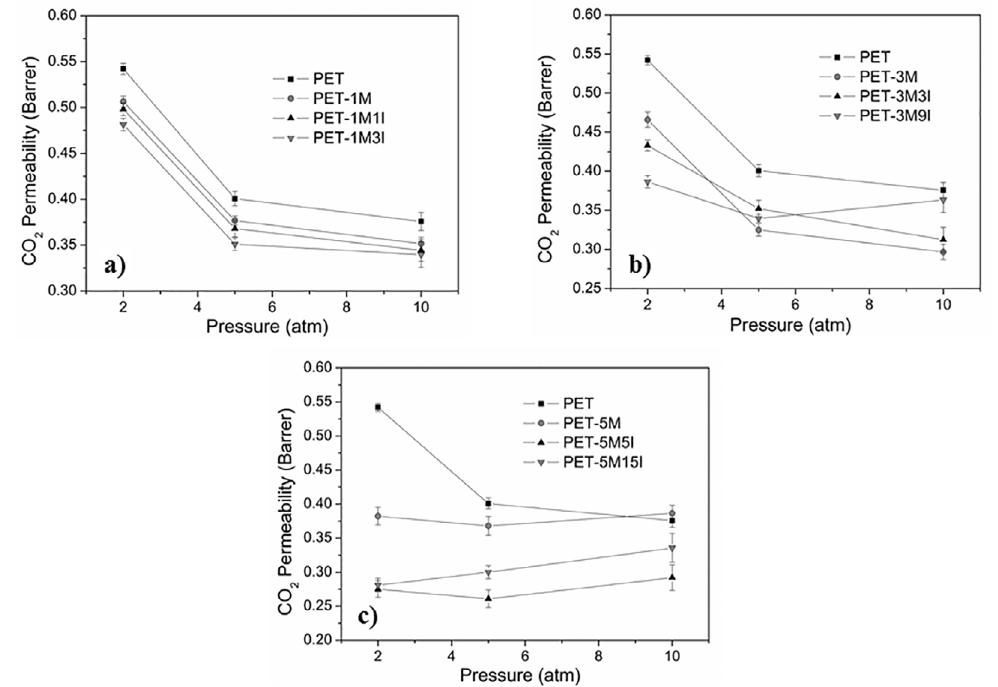
gas permeability of the PET nanocomposites. (a) 1wt%, (b) 2